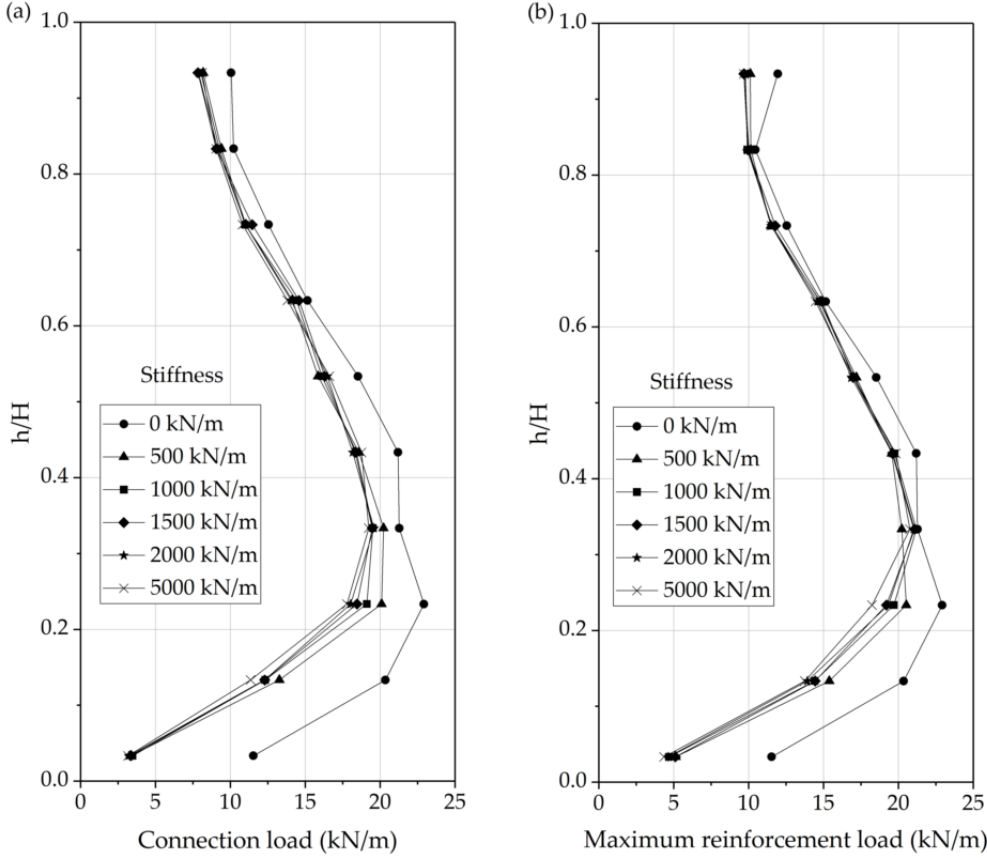
Figure 15. The influence of the secondary reinforcement stiffness on the distributions of ( a ) the connection load; ( b ) the maximum reinforcement load in the primary reinforcement. Table 6. Sum of connection loads and maximum reinforcement loads of walls in each primary reinforcement layer (effect of secondary reinforcement stiffness).